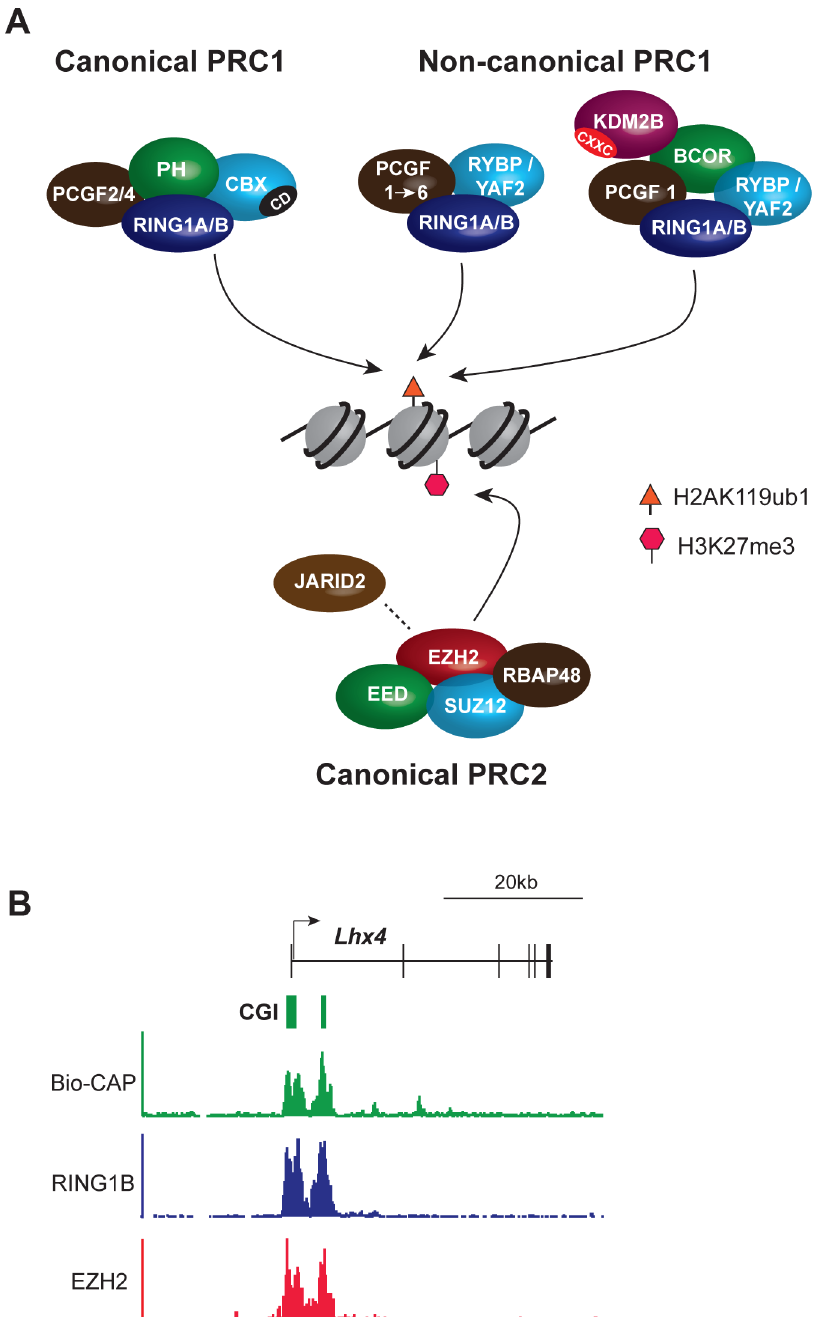
Figure 1. Core components of the major PcG complexes in vertebrate cells overlap with CpG islands. (A) PRC1 complexes catalyze monoubiquitylation of histone H2A lysine 119 (H2AK119ub1). The catalytic subunits are RING1A/B and one of six PCGF protein homologues, PCGF1– 6. PRC1 exists in canonical and noncanonical forms. Canonical PRC1 complexes comprise RING1A/B, PCGF2/4, the CBX protein subunit that has a chromodomain (CD) that binds specifically to PRC2-mediated H3K27me3, and the PH subunit. In noncanonical PRC1, CBX proteins are substituted by the RYBP/YAF2 subunit and the PH subunit is absent. Association of additional subunits with noncanonical PRC1 occurs in a manner dependent on the associated PCGF protein. Thus, PCGF1 complexes, discussed extensively herein, include the additional subunits BCOR and KDM2B. KDM2B has a zinc finger CxxC domain (CXXC) that mediates binding to unmethylated CpG dinucleotides. PRC2 complexes methylate histone H3 lysine 27 (H3K27me1/2/3) and comprise the catalytic EZH2 protein and the core subunits EED, SUZ12, and RBAP48. JARID2 is a substoichiometric subunit that has been implicated in PRC2 targeting. (B) PcG complexes occupy CpG islands at target gene promoters: an example from genome-wide ChIP-seq analysis of mouse embryonic stem cells illustrating a PcG target gene, Lhx4. The Bio-CAP procedure provides a molecular readout of the density of unmethylated CpG dinucleotides with peaks corresponding to CpG islands. ChIP-seq for PRC1 (RING1B) and PRC2 (EZH2) subunits illustrates that PcG protein occupancy closely mirrors unmethylated CpG